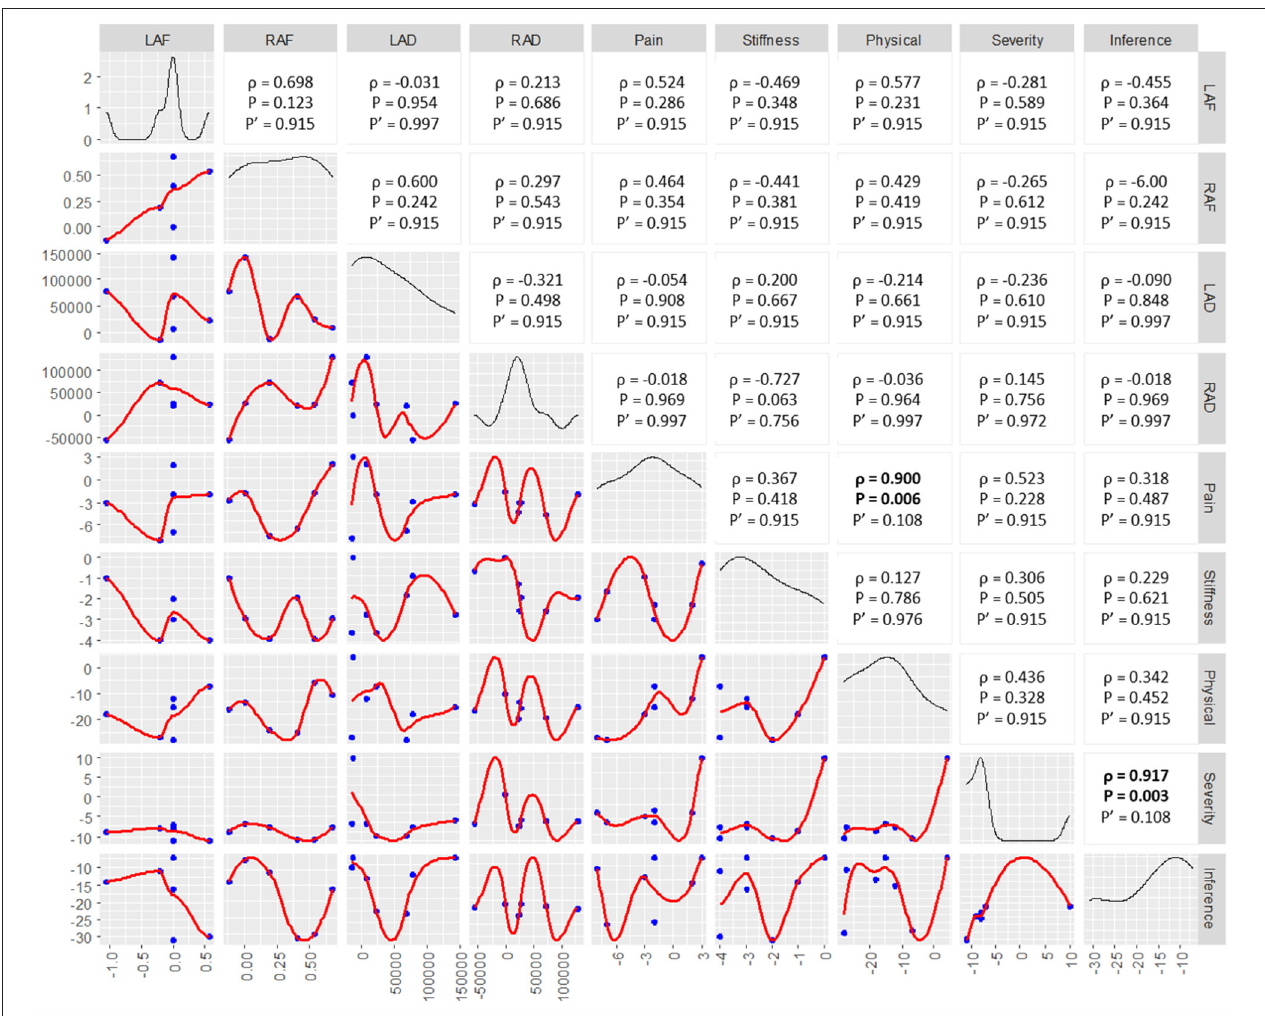
FIGURE 6 | Cross correlations between post- vs. pre-TC intervention changes in amygdala-mPFC rs-fMRI / DTI connectivity and the corresponding changes in pain/physical function. The left lower half of the figure depicts univariate scatter plots with Loess regression lines. The diagonal of the figure depicts probability distribution functions of each variable. The right upper half of the figure presents the Spearman’s rho ( ρ ) of each univariate correlation, the corresponding unadjusted p -value ( p ) and the p -value adjusted for using the Benjamini-Hochberg procedure ( p ’). LAF, L/amygdala-mPFC functional connectivity; RAF, R/amygdala-mPFC functional connectivity; LAD, L/amygdala-mPFC DTI connectivity; RAD, R/amygdala-mPFC DTI connectivity; Physical, physical